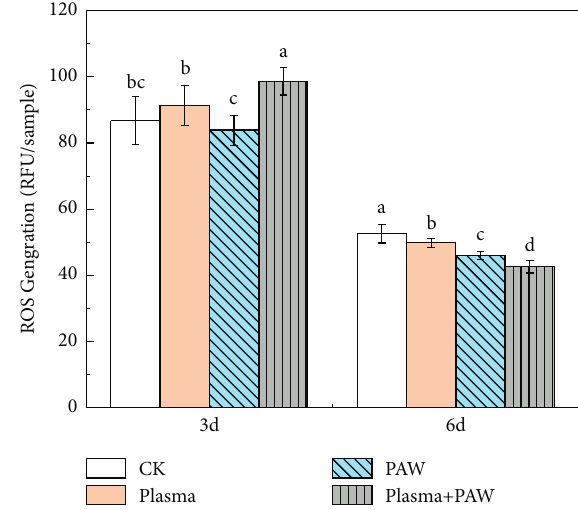
Figure 16: Content of reactive oxygen species in Astragalus adsurgens Pall seedlings (different letters indicate statistically sig- nificant differences between treatments ( p < 0 .